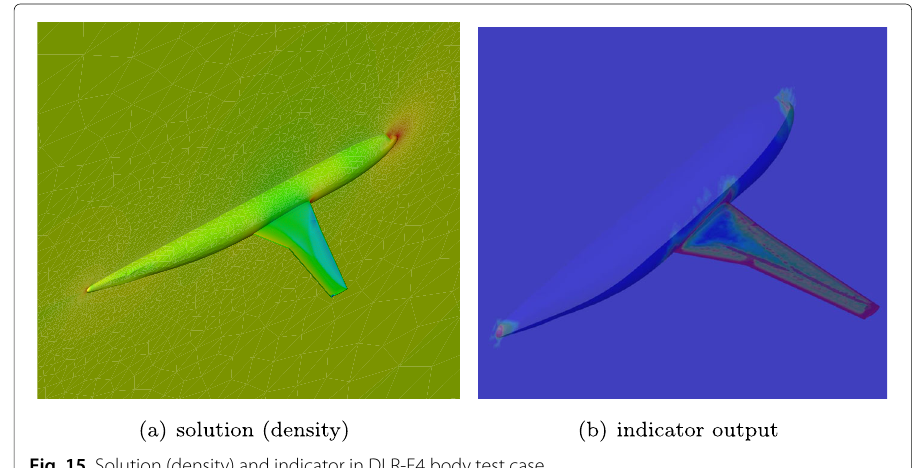
Fig. 15 Solution (density) and indicator in DLR-F4 body test case